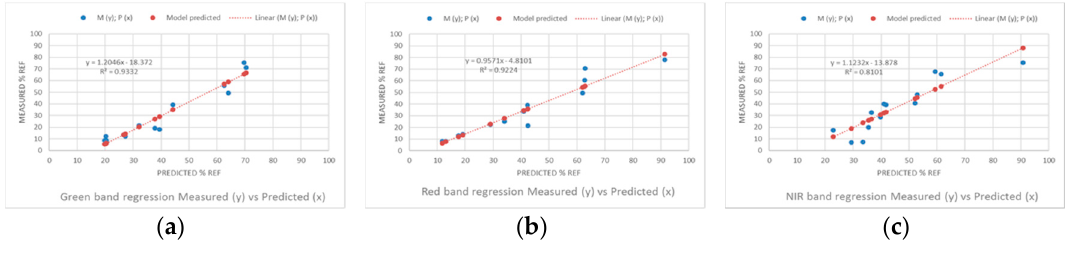
Figure 10. Ascending order M (red line) and P reflectance plots for G ( a ); R ( b ) and NIR ( c ) bands from EL2 Dulux . The OLS plots of measured (M) regressed against predicted (P) reflectance values per camera waveband are shown in Figure 11 below.